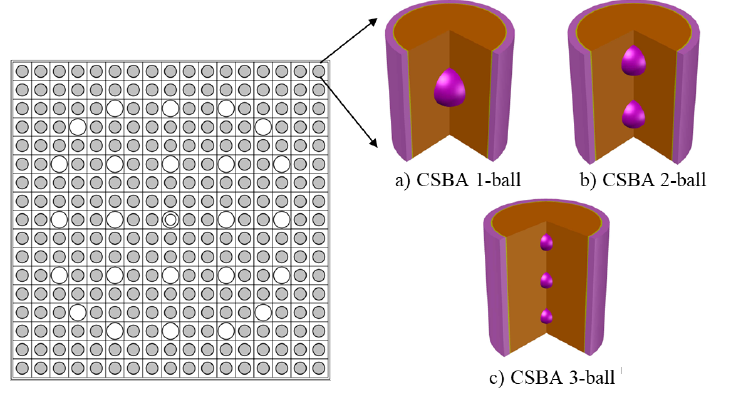
Figure 1: 17x17 CSBA-loaded Fuel Assembly